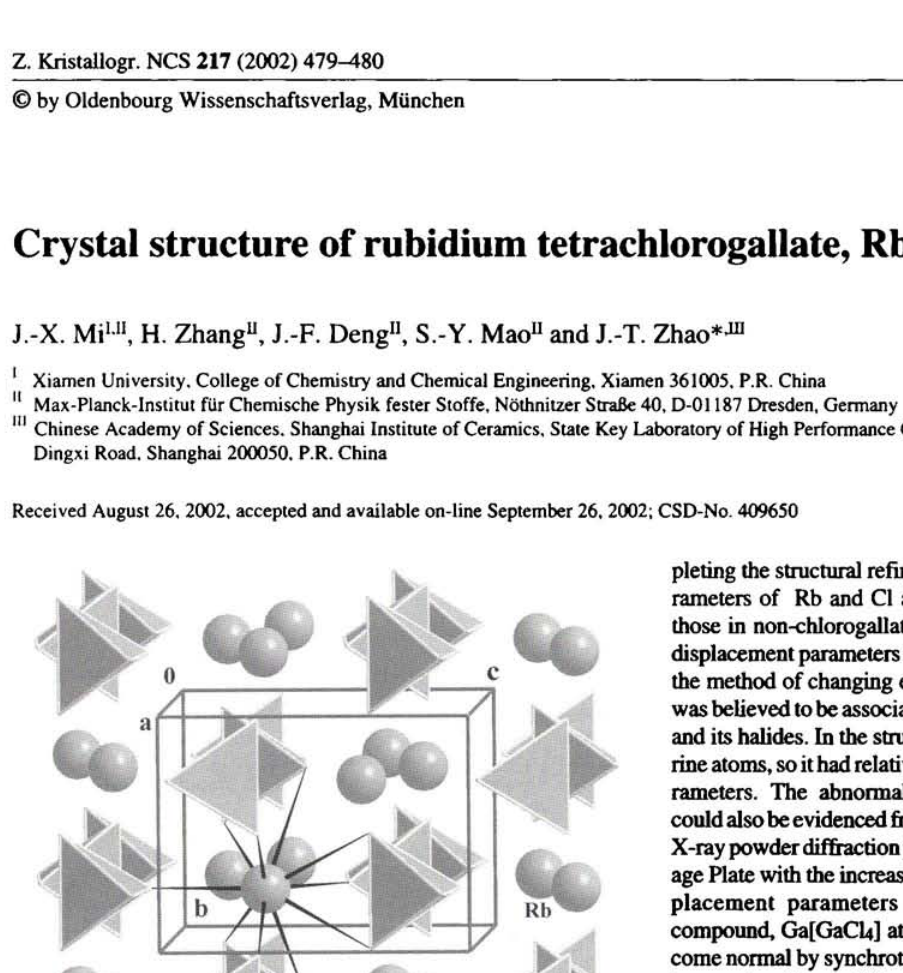
Table 1. Data collection and